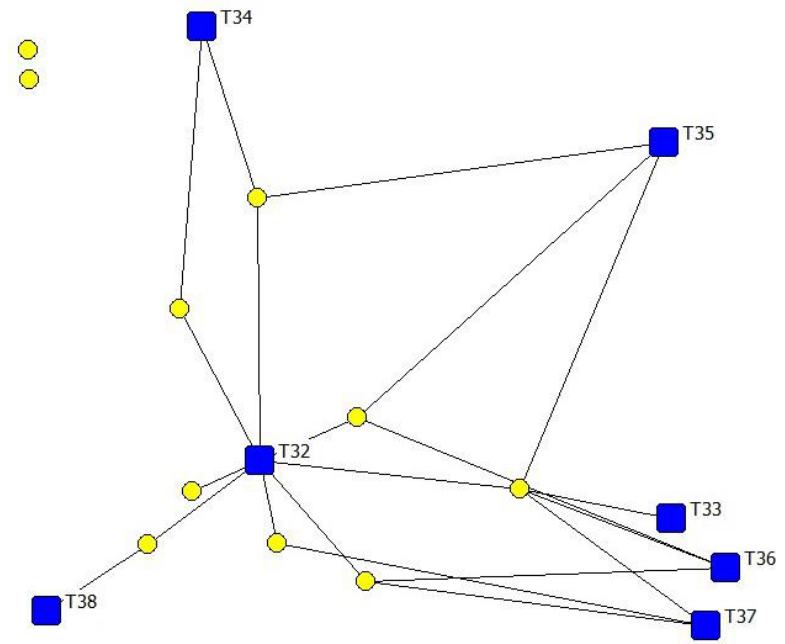
Figure 3. Two - mode network visualization of farmers and technologies.